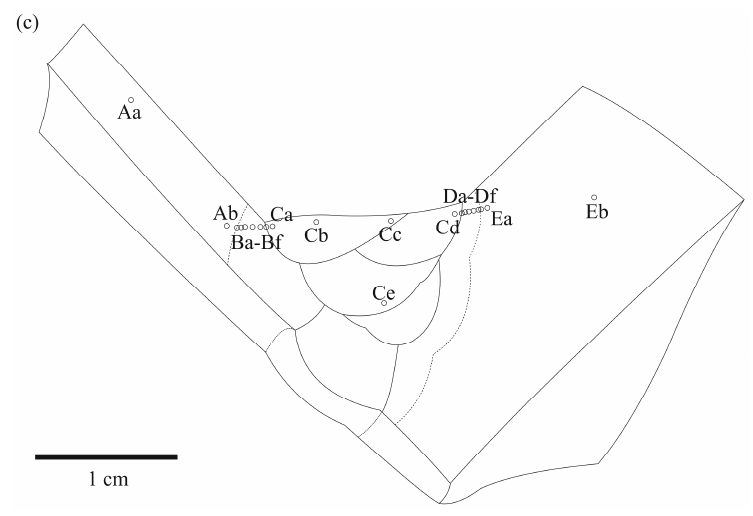
Figure 3. ( a ) Macrostructure; ( b ) schematic; and ( c ) examined positions of the weld.